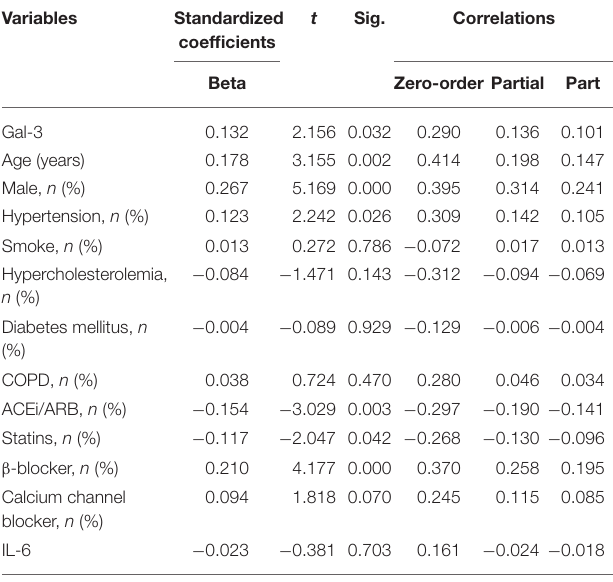
TABLE 3 | Multivariate linear analysis of Gal-3 for aortic diameter, including partial correlation